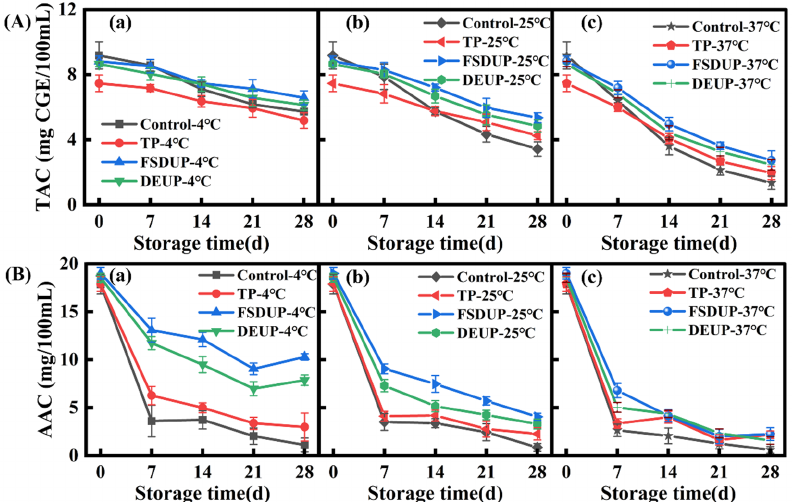
Figure 5. Changes in total anthocyanin content ( A ) and ascorbic acid content ( B ) of strawberry clear juice during storage after thermal pretreatment and multi-mode thermosonication. TAC: total anthocyanin content; AAC: ascorbic acid content; TP: thermal pretreatment; FSDUP: flat sweep-frequency dispersive ultrasound pretreatment; DEUP: dual-frequency energy-gathered ultrasound pretreatment.